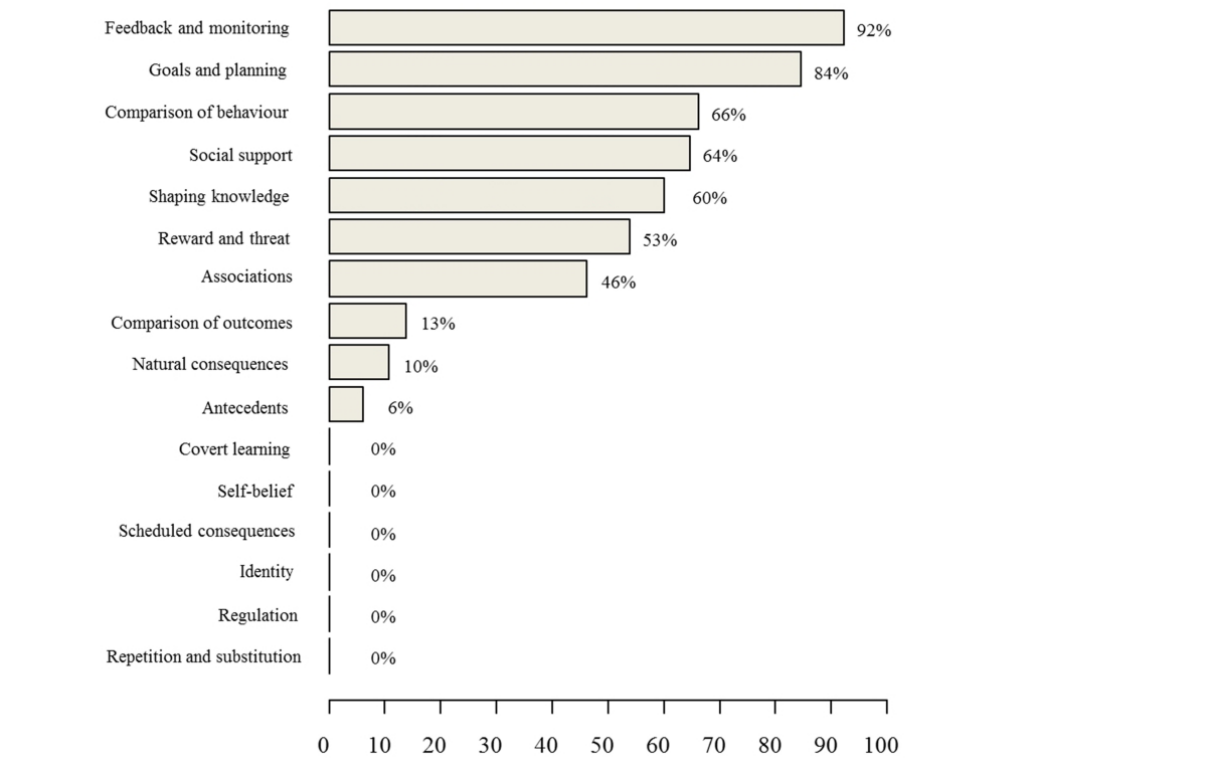
Figure 2. Frequency of behavior change techniques (BCTs) incorporated by physical activity (PA) apps, presented by BCT